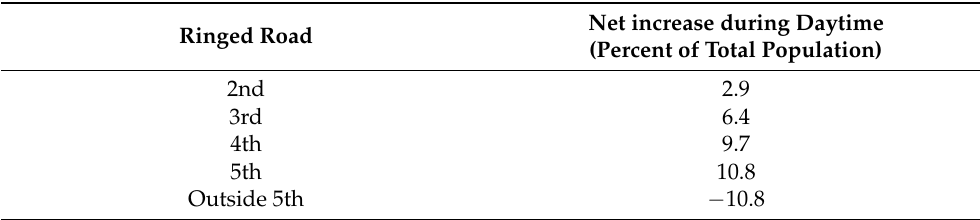
Net increase during Daytime